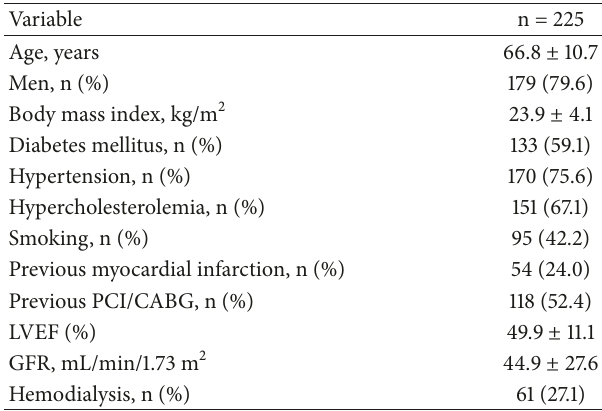
Table 1: Baseline patient